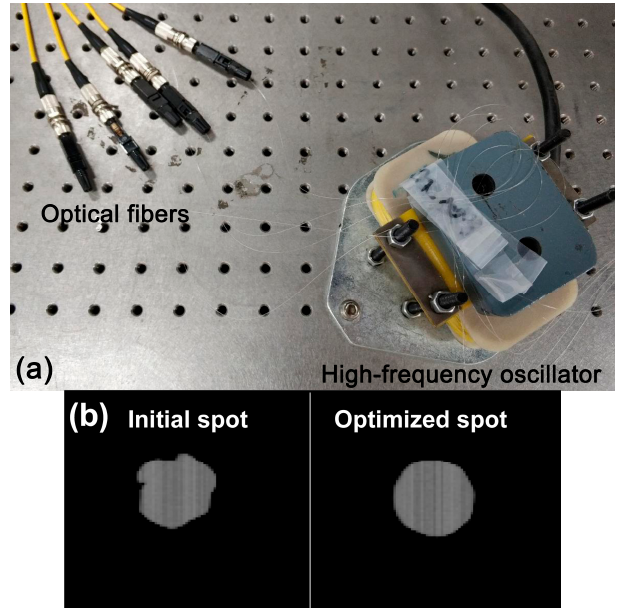
Figure 5. The coupling efficiency of the optical sensor for different RIs in two different positions: ( a ) the modeling diagram of Zemax; ( b ) simulation results.